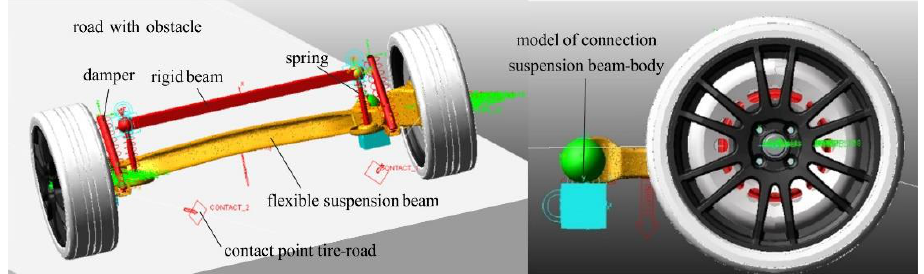
Figure 6. Numerical model of the rear suspension system of the Fiat Panda II.